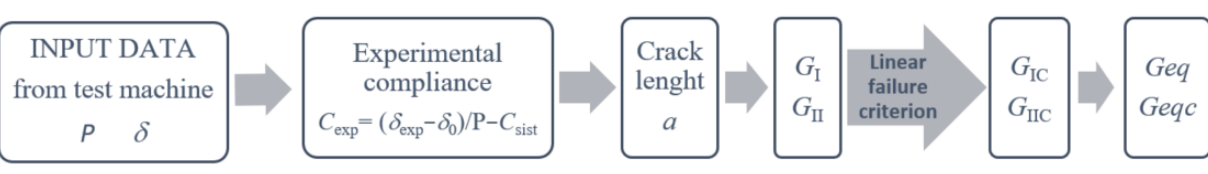
Figure 8. Data reduction scheme.